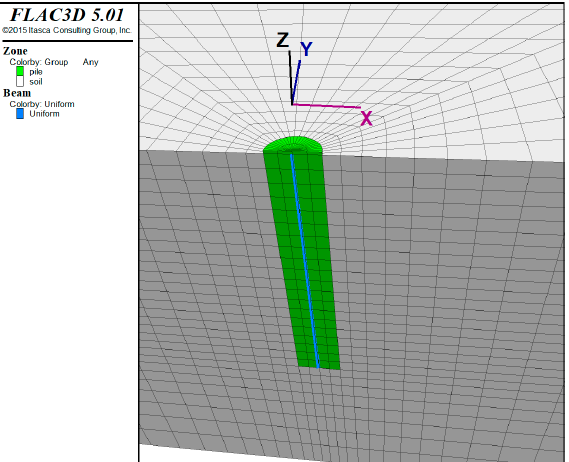
Figure 6. Numerical modelling of the pile.